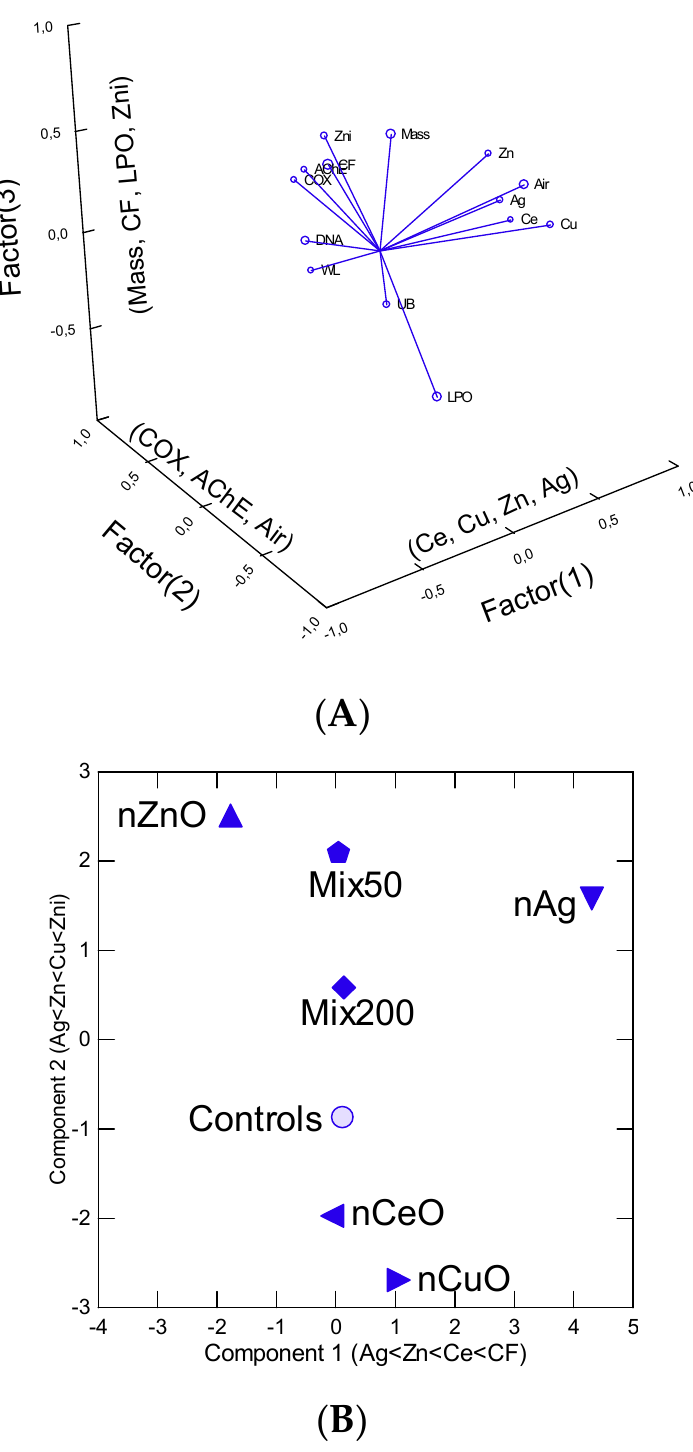
Figure 6. Multivariate analysis of biomarker data. The biomarker data were analysed by factorial (principal component: ( A )) and discriminant function ( B ) analyses. For factorial analysis, the biomarkers with the highest factorial weights are indicated at each axis. For discriminant function analysis, the mean classification efficiency was 73% and the first 4 biomarkers with high factorial weights are included in both axes.